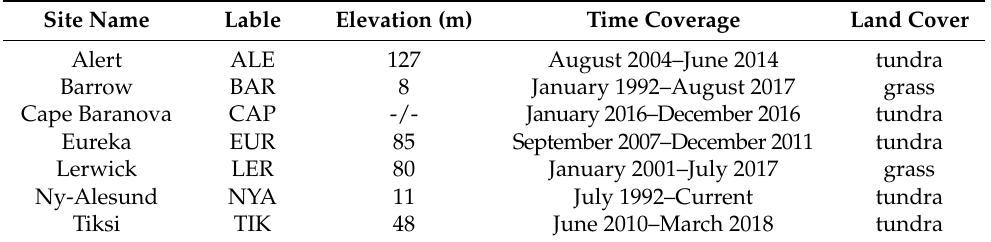
Figure 2. Validation of the CERES SSF FOV clear-sky LWDR products using the BSRN ground measurements at the 7 BSRN sites in the Arctic. ( a − c ) are the validation results for the clear-sky LWDR of the Terra, Aqua, and both payloads, respectively. ( d ) shows the locations of all 7 BSRN sites in the Arctic. Table 2. A brief summary of the information of the 7 BSRN sites located in the Arctic.